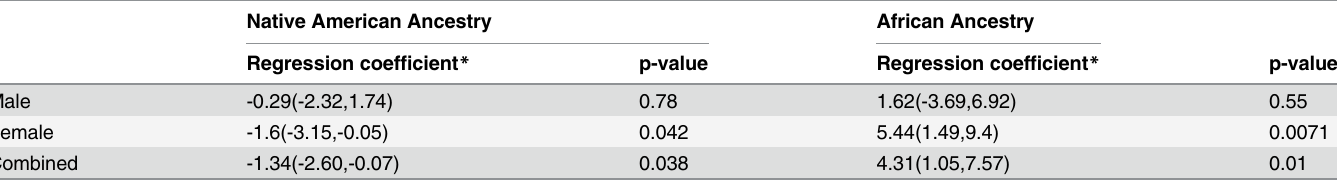
Table 3. Association between genetic ancestry and BMI.